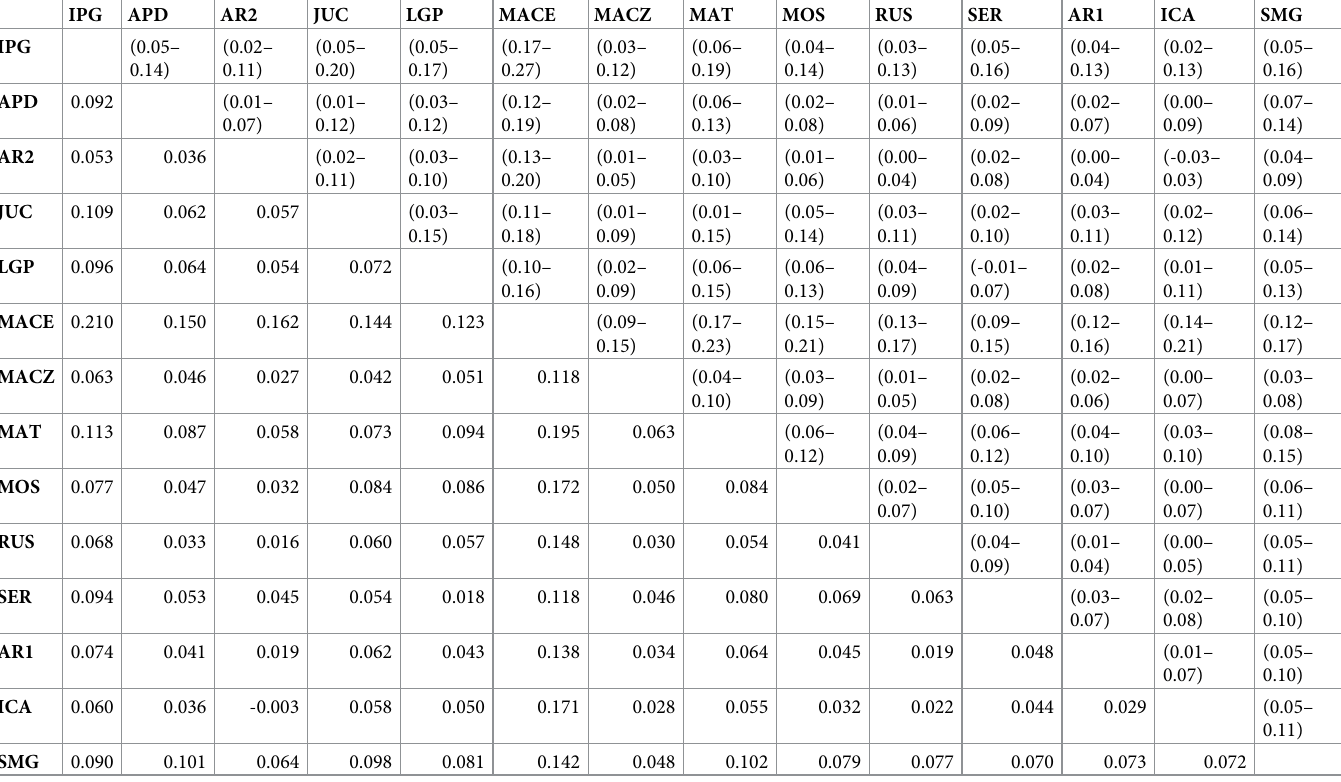
between populations of C . prunifera (lower diagonals). Upper diagonals contain the lower and upper limits of the confidence